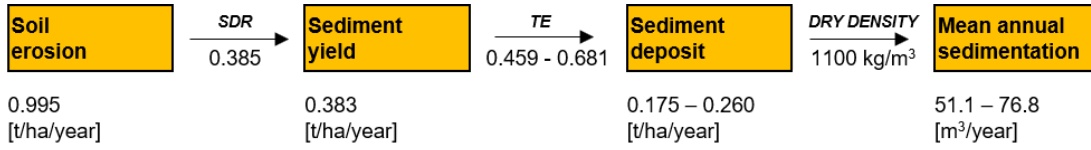
Figure 8. Summary of the modeling approach for the estimation of the reservoir’s mean annual sedimentation rate.